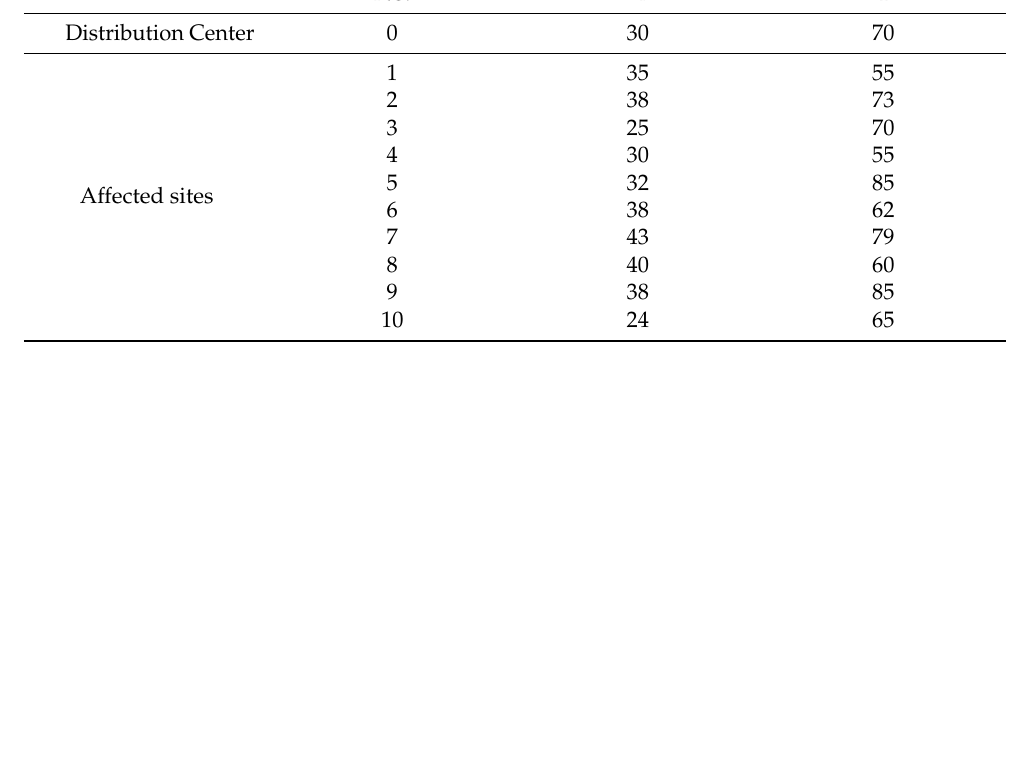
Table 3. Coordinates of the distribution center and locations of affected points. No.